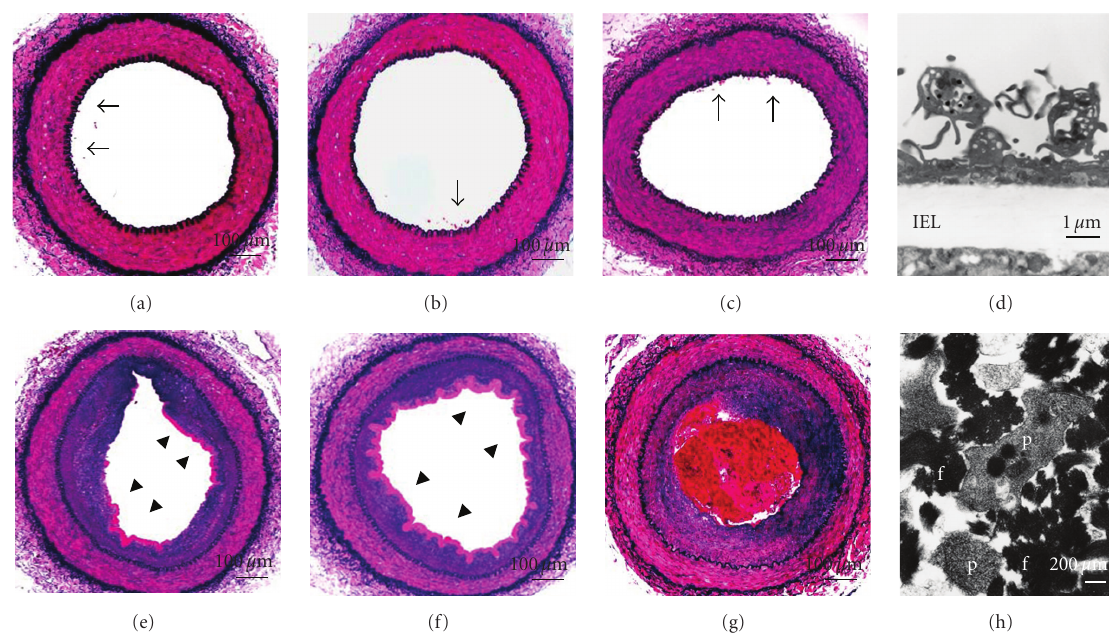
Figure 7: Mural thrombus growth on neointima after blood flow reduction. Small thrombi (arrows) are induced by balloon injury of normal femoral artery without (a) or with blood flow reduction to 50% (b) or 25% (c). Transmission electron micrograph (d) shows that thrombi consist of aggregated platelets (IEL, internal elastic lamina). Platelet fibrin-rich mural thrombi (arrow heads) are induced by balloon injury of neointima without (e) or with blood flow reduction to 50% (f). Neointimal injury with blood flow reduction to 25% causes occlusive thrombus formation (g). Transmission electron micrograph (h) shows that these thrombi are composed of abundant fibrin strands (f) admixed with platelets (p). Hematoxylin eosin/Victria blue stain (a-c, e-g). (from Yamashita et al. [27] with